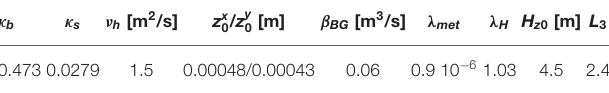
TABLE 4 | Control parameters estimated with the 4DVAR